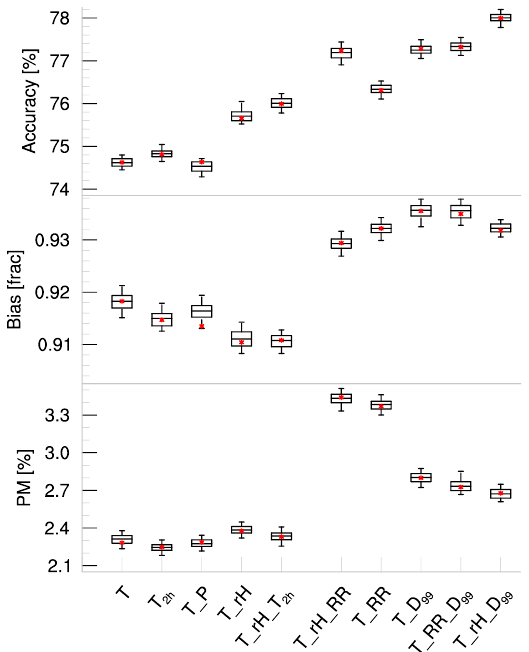
Figure 6. Performance of fit is shown for different combinations of atmospheric variables as in Fig. 4 for RSM sub-data. All variable combinations again include T